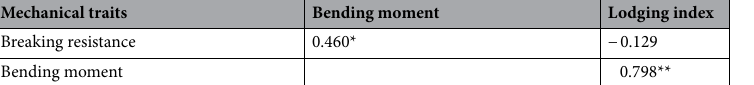
Table 4. Correlation coefficients between lodging index and mechanical traits in synthetic hexalpoid wheat in the field. * And ** indicate significant at the P < 0.05 and P < 0.01 levels, respectively.